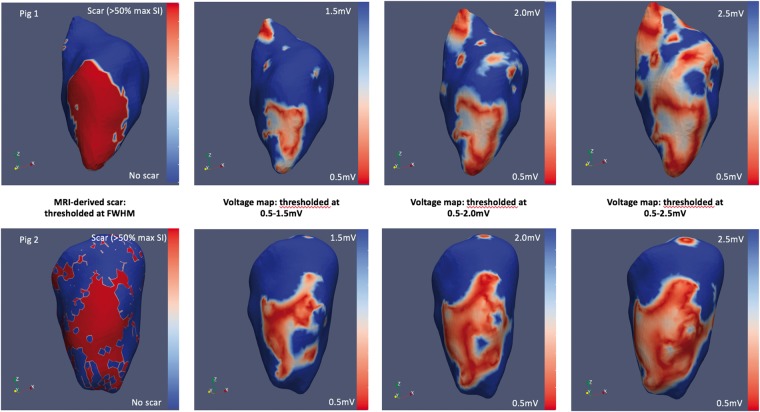
Sorenson–Dice similarity co-efficient between MR-derived scar shells (far left panels) and endocardial voltage maps with varying normal voltage thresholds (right panels) in two representative animals. FWHM, full-width-half-maximum; MR, magnetic resonance; MRI, magnetic resonance imaging.